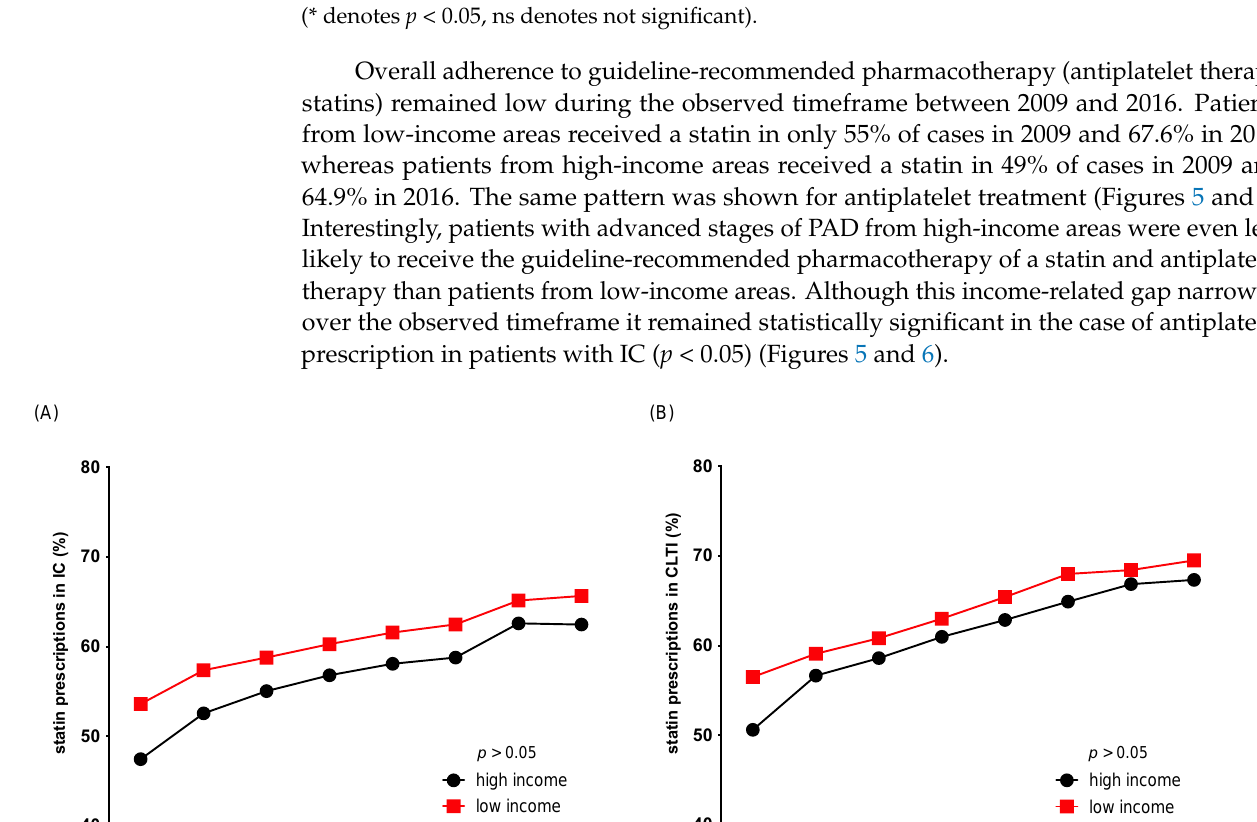
Figure 6. Adherence to guideline-recommended antiplatelet pharmacotherapy between 2009 and 2016, stratified by income level and stage of disease: intermittent claudication (IC) ( A ), critical limb- threatening ischemia (CLTI) ( B ). 4. Discussion Atherosclerotic cardiovascular diseases are the leading causes of mortality and mor- bidity in the industrialized world, with substantial associated healthcare costs [30]. Studies have shown a well-established link between income and health, pointing out that people with high income are less likely to live unhealthily [31]. A Spanish study showed that preventing income disparities is an effective way to reduce health inequality [32]. Especially for cardiovascular diseases, income levels are strong predictors of cardio- vascular health [2,25,33]. Subsequently, it was shown that the risk of lower extremity am- putation is higher in metropolitan regions with a lower socioeconomic status [34,35]. So- cioeconomic factors and education, as well as area-level socioeconomic indicators, are in- dependent contributions to PAD onset [36]. Our study now shows that income is an important but non-linear factor potentially associated with presentation to vascular specialists and regarding prescription of guide- line-recommended medical therapy. Our data highlight that patients from high-income